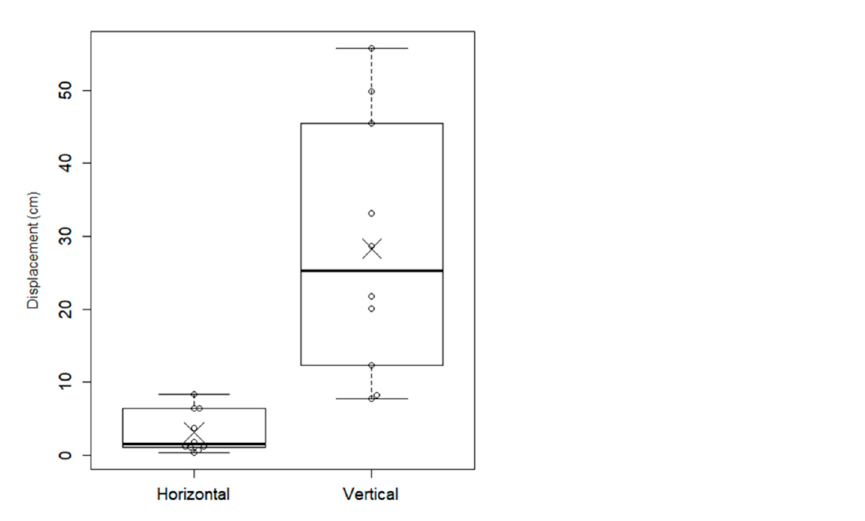
Figure 2. Box-and-whisker plots of the maximum horizontal and vertical displacements from the beginning of the tree-pulling experiment until reaching the maximum critical turning moment in Pinus thunbergii trees. The median value is shown as a horizontal black line inside the box; the first and third quartiles are the bottom and top of the box, respectively. Each line vertically extending from the box represents 1.5 times the interquartile distance. The mean is shown as an x mark. Univariate scatter plots show data points of 10 individual trees.